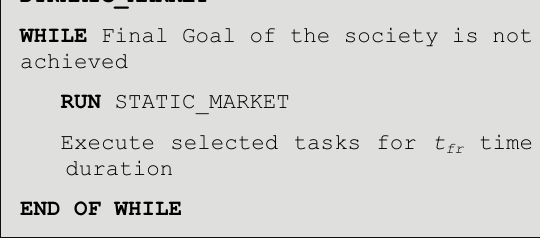
Fig. 2. Decision making algorithm in dynamic markets